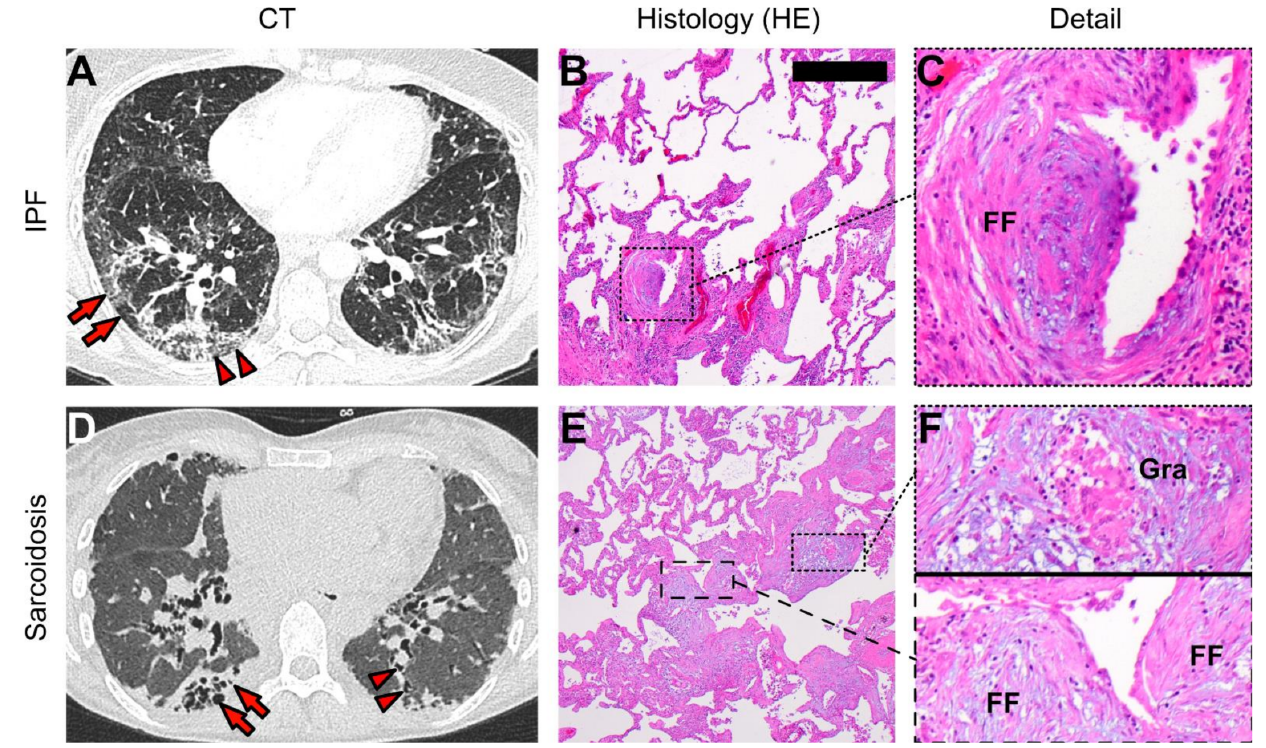
Figure 1. Radiological and histopathological features of sarcoidosis and IPF. ( A ) Exemplary axial high resolution computed tomography (CT) slide showing typical radiological predominantly subpleural distributed features of idiopathic pulmonary fibrosis (IPF) including septal thickening, mixed ground glass opacities, reticular densities (arrowheads), and areas of subpleural honeycombing (arrows); ( B ) typical histopathological features of IPF including disturbed pulmonary architecture (i.e., aberrant alveoli with hyperplastic bronchiolar epithelial lining, extensive myogenic metaplasia, and multiple fibroblastic foci (FF) magnified in ( C ); ( D ) exemplary axial high resolution CT slide showing typical hallmarks of fibrotic pulmonary sarcoidosis including reticular and cystic changes, traction bronchiec- tasis (arrowheads), and subpleural bullous changes (arrows); ( E ) histopathological hallmarks of sarcoidosis including focal organizing pneumonia and interstitial pneumonitis as well as the in ( F ) magnified multiple granuloma (Gra) with central giant cells and surrounding epithelioid cells and FF; HE, hematoxylin-eosin stained; scale bar equals 500 µ